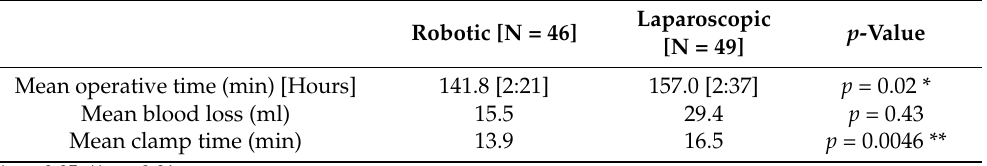
Table 3. Peri-operative outcomes of robotic assisted and laparoscopic assisted partial nephrectomy groups. Laparoscopic p -Value Robotic [N = 46] [N = 49] Mean operative time (min) [Hours] 141.8 [2:21] 157.0 [2:37] p = 0.02 * Mean blood loss (ml) 15.5 29.4 p = 0.43 Mean clamp time (min) 13.9 16.5 p = 0.0046 **